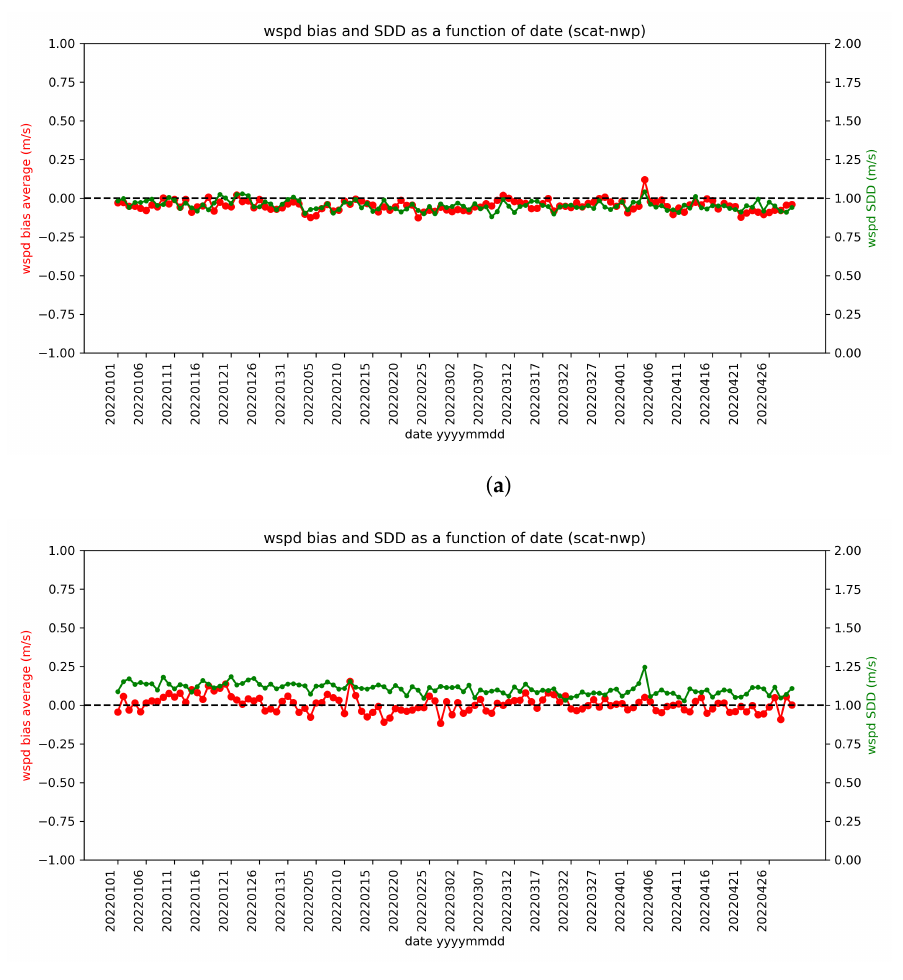
Figure 19. Wind speed bias and its SDD as a function of date (with NOCant+), from 1 January to 30 April 2022: ( a ) Ku-band, ( b )